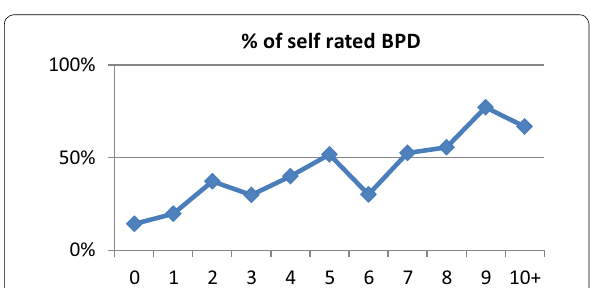
5 self-rated BPD criteria ≥